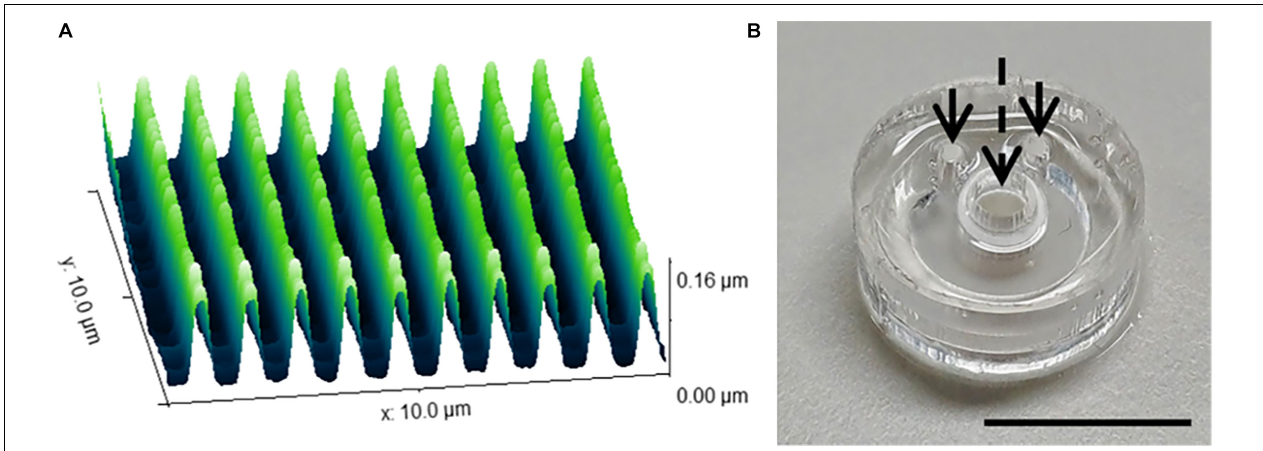
FIGURE 2 | Nanogrooved pattern and microbioreactor fabrication for 2D and 3D neuronal cell culture devices. (A) Atomic force microscopy image of a 10 × 10 µ m 2 area of nanogrooves with a pattern period of 990 ± 22 nm and a ridge width of 246 ± 22 nm ( n = 5) as used in the cell culture experiments with nanogrooved substrates. With permission from the open access article of Bastiaens et al. (2019b, Figure 3A) under the CC-BY license. (B) A microbioreactor polydimethylsiloxane (PDMS) gasket with cylindrical polyehtersulfone (PES) tube prior to bonding the microbioreactor to a glass cover slip. The arrows denote the inlets for the microfluidic channel, the dashed arrow denotes the cell culture chamber in the center of the PES tube for which a PES tube acts as a membrane to exchange nutrients and waste with the microfluidic channel. Scale bar denotes 1 cm. With permission from the open access article of Bastiaens et al. (2018a, Figure 2C) under the CC-BY license.